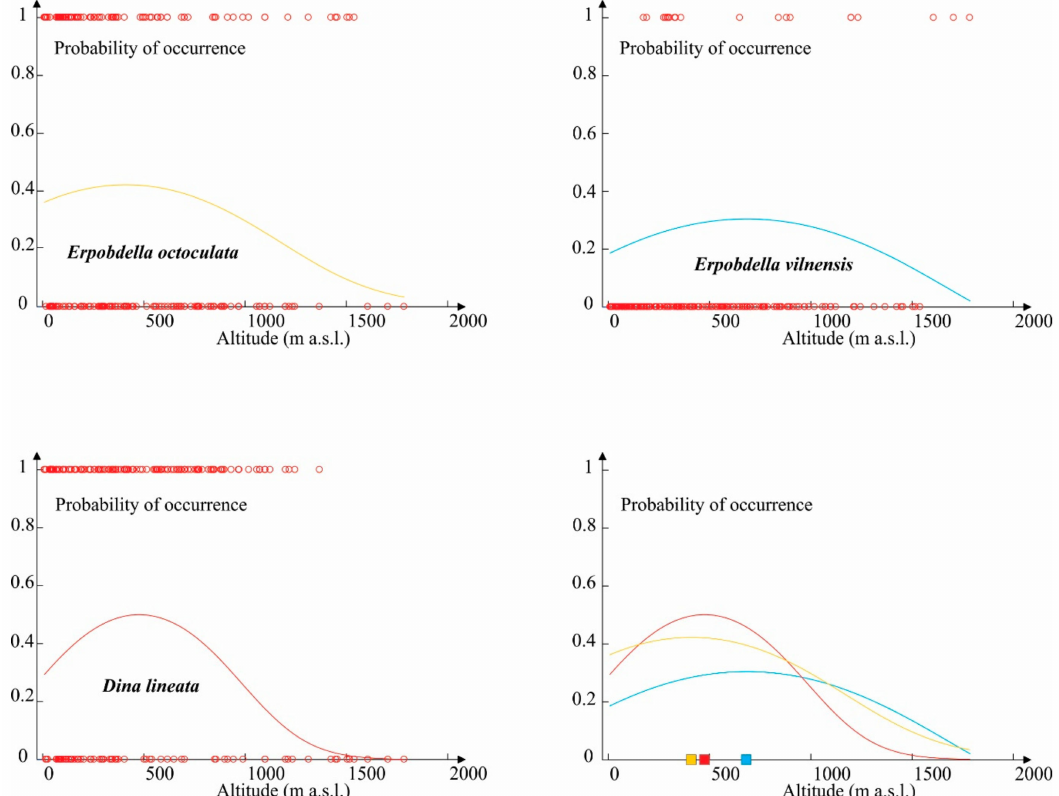
Figure 6. The ecological di ff erentiation of the the analyzed species with respect to altitude. Circles denote either the presence (1) or absence (0) of a species at a particular site. Response functions specify the probability of occurrence of taxa along the gradient. Square symbols on the abscissa of the combined diagram represent the optimum value for each